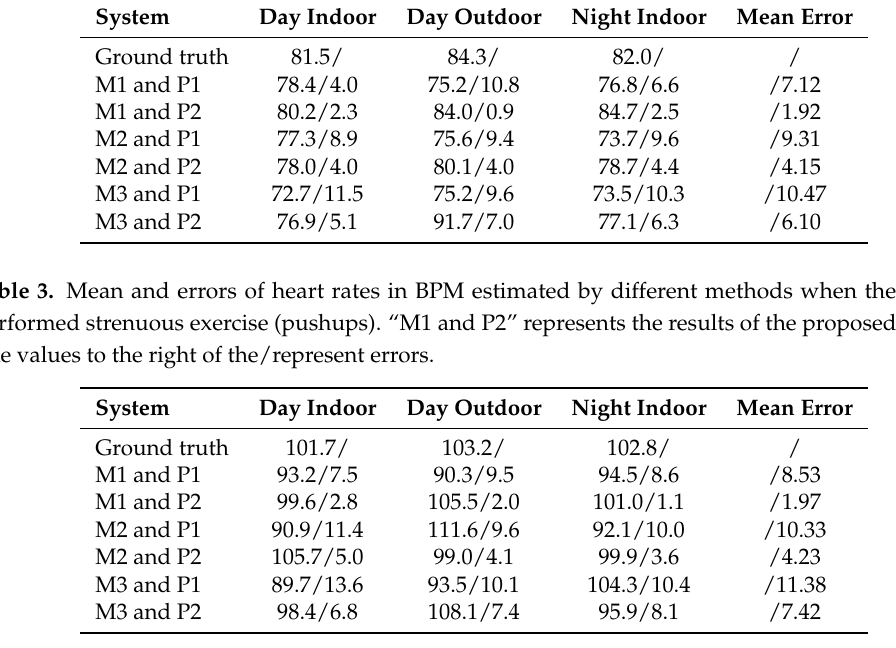
Table 2. Mean and errors of heart rates in BPM estimated by different methods when the subject performed warm-up exercise (moving up and down stairs). “M1 and P2” represents the results of the proposed system. The values to the right of the/represent errors.